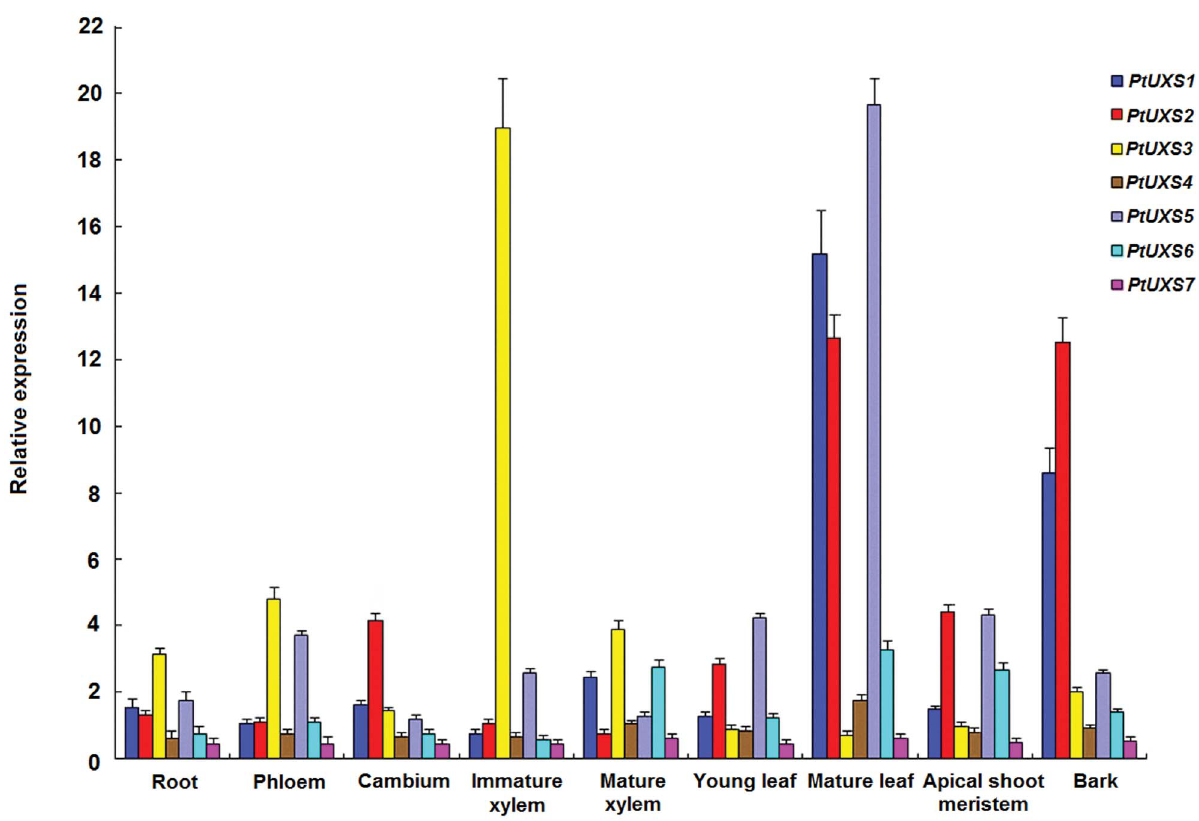
Figure 3. Relative transcript levels of seven PtUXS family members in different tissues and organs. Transcript levels were measured in different tissues, as indicated, by quantitative RT-PCR and is normalized to expression of Actin . Error bars represent + SD.